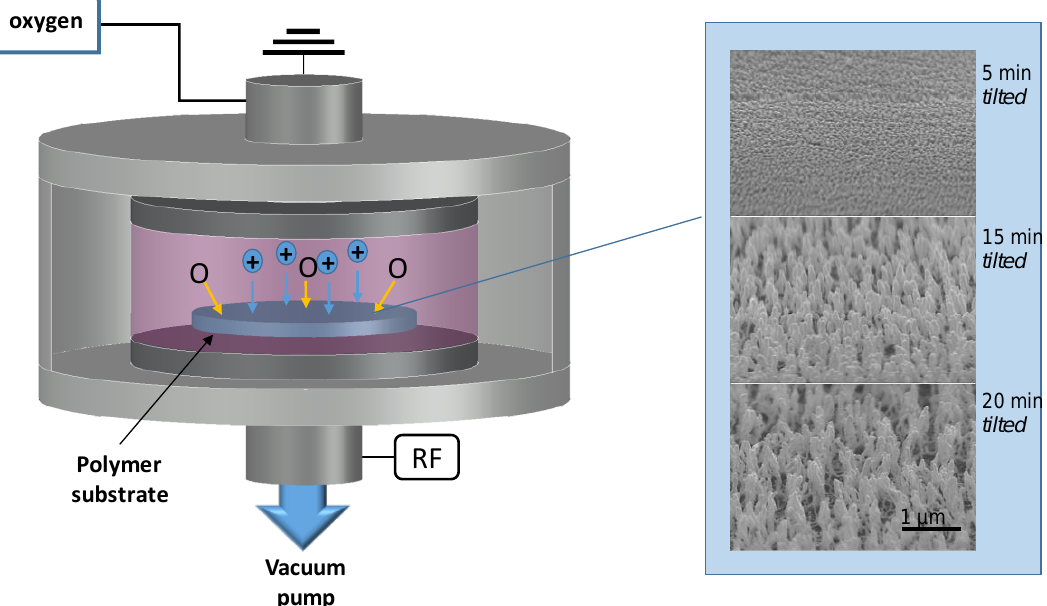
Figure 1. A sketch illustrating a typical plasma nano-texturing process of a polymer. Scanning Electron Microscopy (SEM) tilted pictures of polycarbonate adapted with permission from [43]. Copyright 2011 John Wiley and Sons.